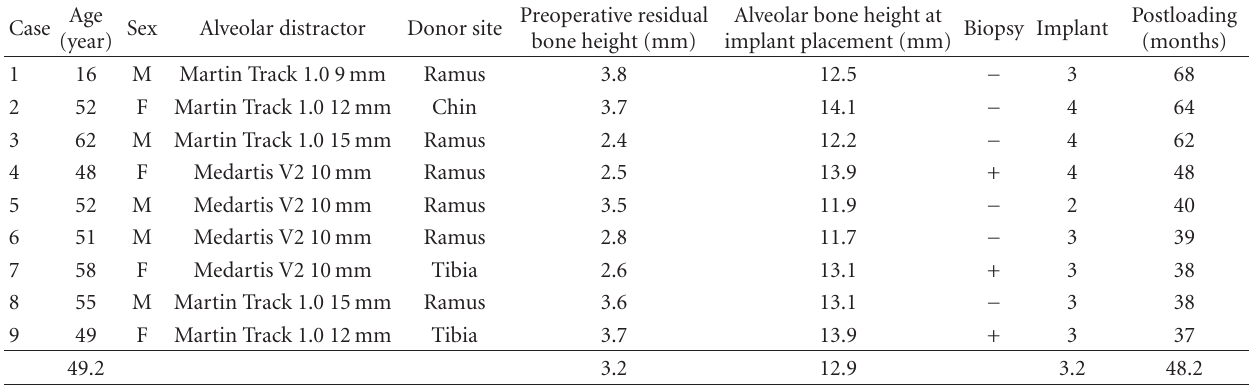
Table 2: Patient profiles and review ( n = 9) for unilateral sinus lifting and simultaneous unilateral alveolar distraction for the unilateral partially edentulous severely atrophic posterior maxilla. Unilateral sinus lifting + Alv. DO for partially edentulous patients. Age Case (year)